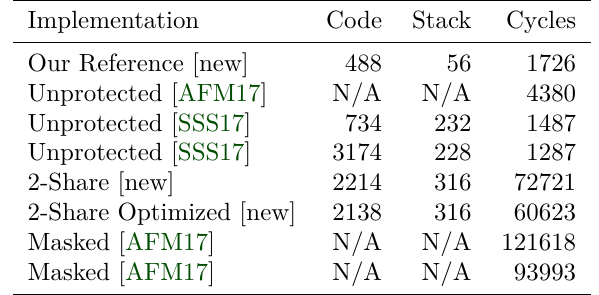
Table 3: Code sizes and runtime cycle counts for the tested